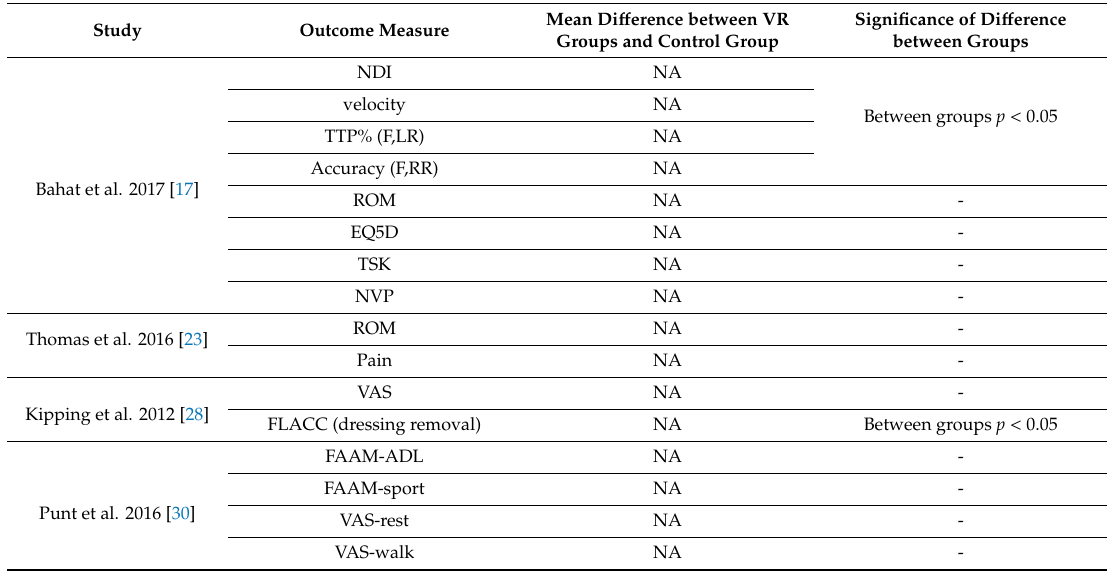
Table 4. E ff ect of VR versus no